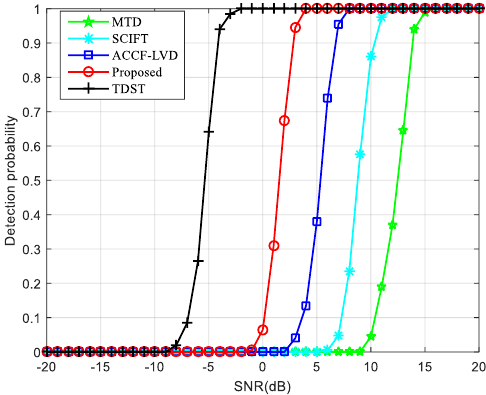
Figure 8. Detection probability of five algorithms.